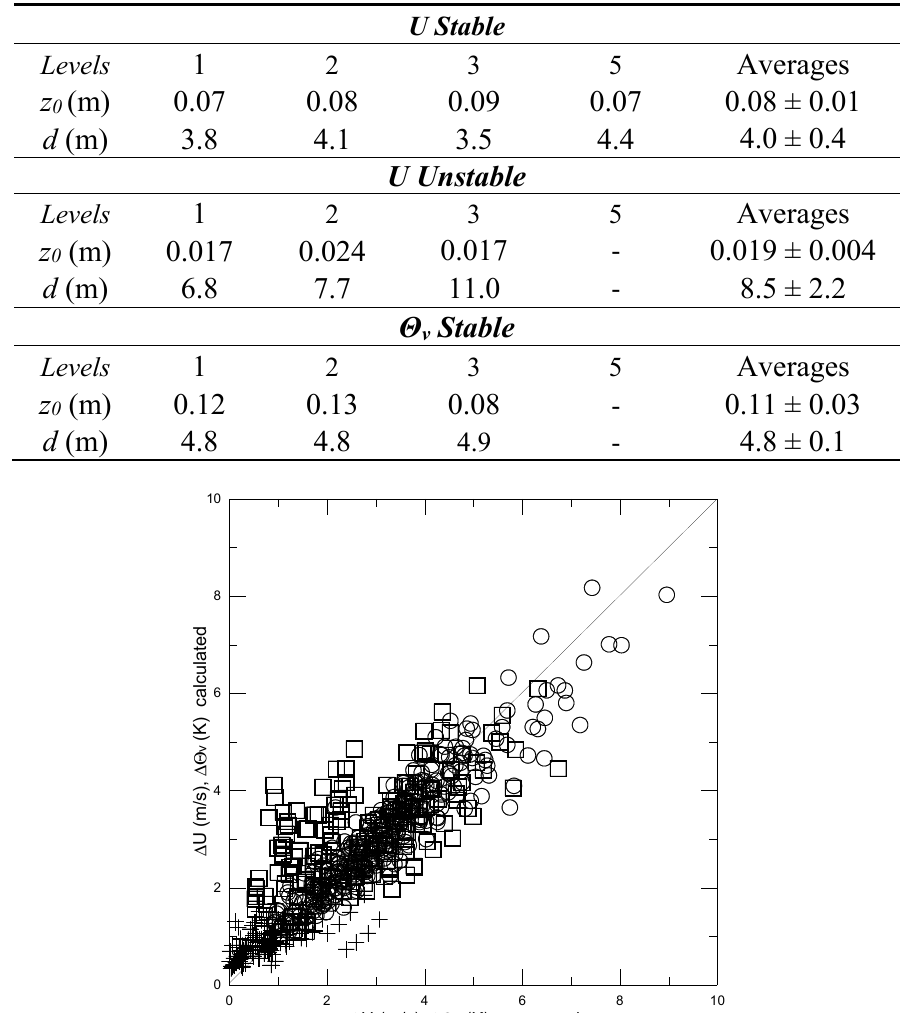
Table 2. d and z 0 calculated as in M00 (Martano approach), with average values of a from Table 1.